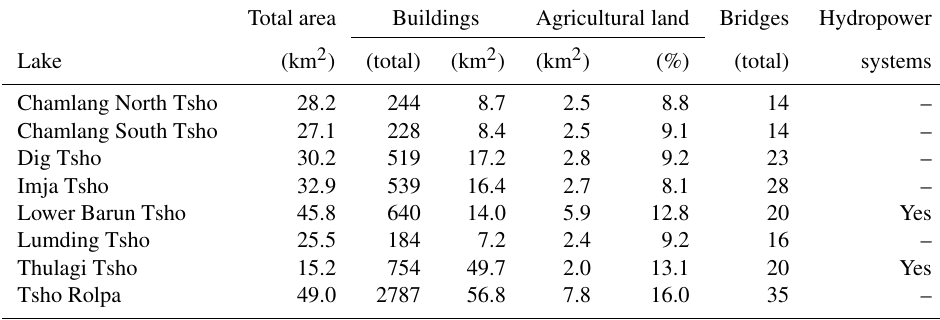
Table 7. Details of downstream impacts from the MC-LCP GLOF models for each glacial lake. Total area Buildings Agricultural land